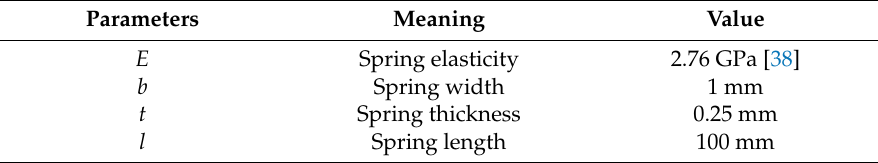
Table 1. The geometric parameters of the spiral